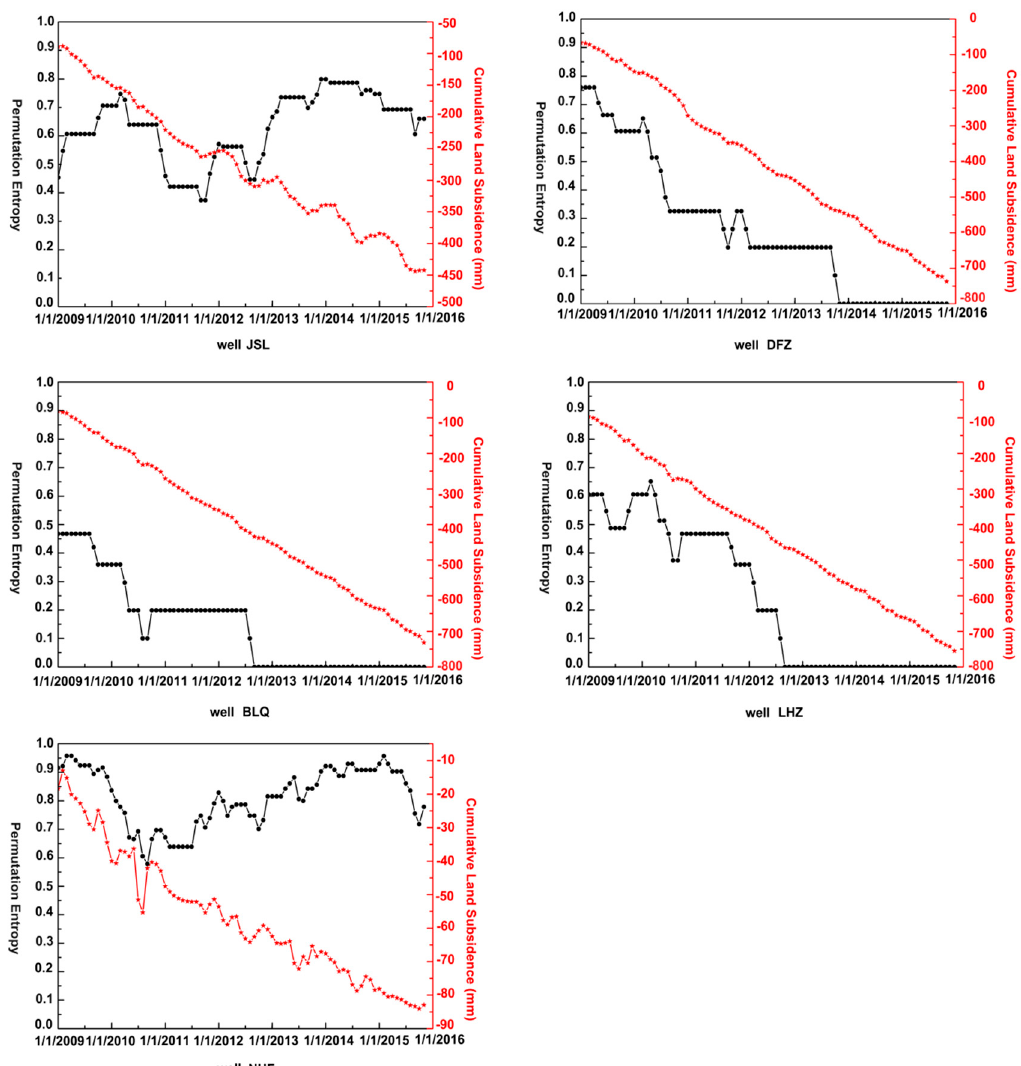
Figure 8. The PE results for the five wells.The black lines indicate the PE values, and the red lines represent the cumulative land subsidence from 2009 to 2015.